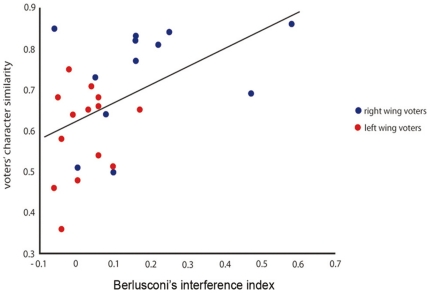
Correlation between participants perceived personality similarity with Berlusconi and his interference effect.On the y axis, the similarity scores, ranging from 0 (not similar at all) to 1 (completely similar) computed as described in the Methods. On the x axis, the interference index deducted by the difference between the accuracy (percentage of correct responses) in congruent minus incongruent trials.